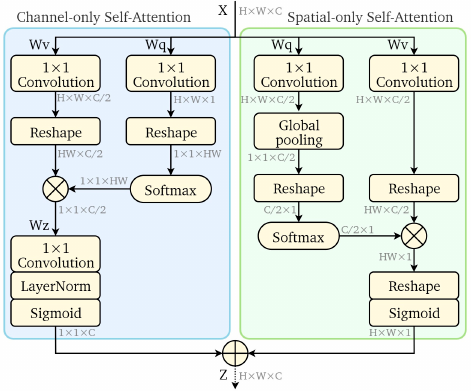
Figure 3. Structure diagram of attention mechanism in the AMFF module. Attentional weights are calculated at the channel and spatial dimensions.